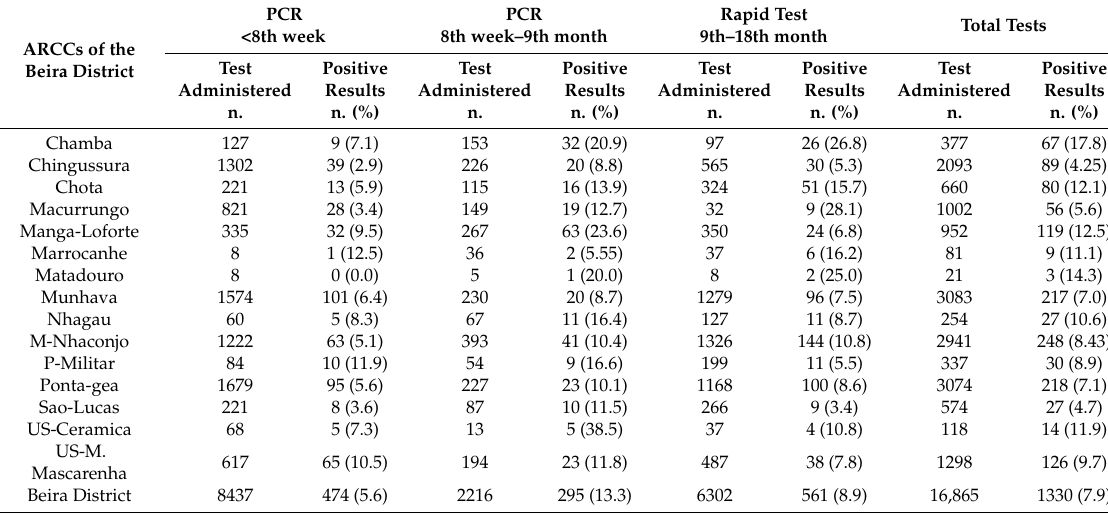
Table 2. First HIV test, by timing and type (PCR, Rapid Test), administered during the first consultations at the 15 ARCCs of the Beira District,